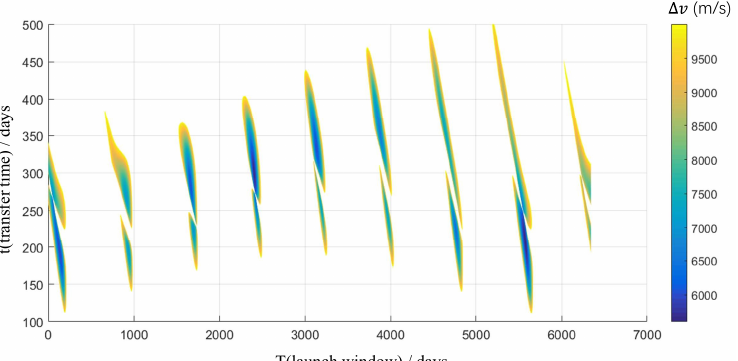
Figure 6. Total ∆ v for Mars-to-Earth Lambert transfer from 2035 to 2050. The horizontal axis is launch windows (in days after 1 January 2035), and the vertical axis is transfer time (in